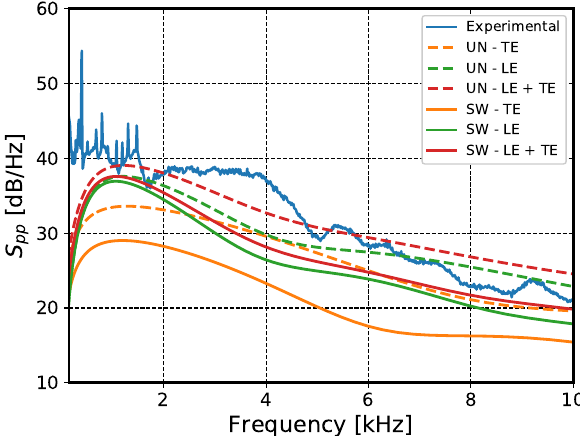
Figure 12. PSD of the far-field emitted sound by the fan at its nominal working point: the solid red line representing the summation of trailing-edge (TE) and leading-edge (LE) noise contributions for the swept case (SW) is in fairly good agreement with the experimental curve in solid blue, especially at high frequency, resulting into a better description of the noise emission with respect to the unswept (UN) classical Amiet’s formulation shown in dashed line. In this plot, Lee’s model and Corcos’ model with m = 1 and n = 1 are employed for the TE noise prediction, whilst the von Kármán’s model is used for the LE noise